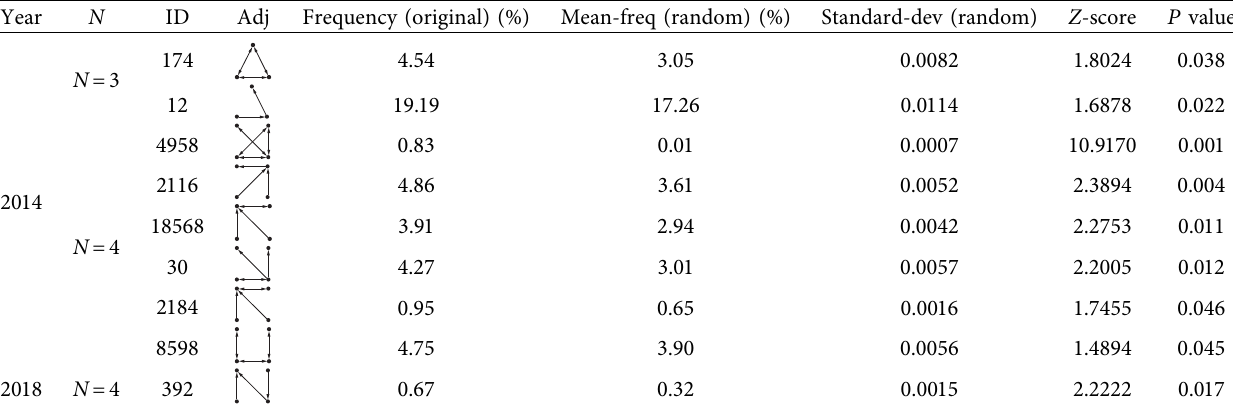
Table 1: Analysis of freight network motifs.